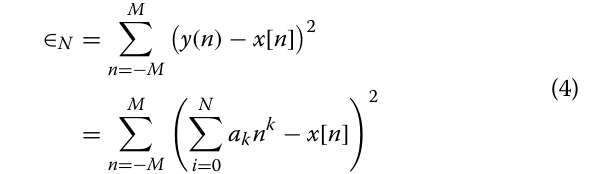
Fig. 2 Capacity curve of LIB with the number of cycles (B0005, B0006, B0007 and B0018)